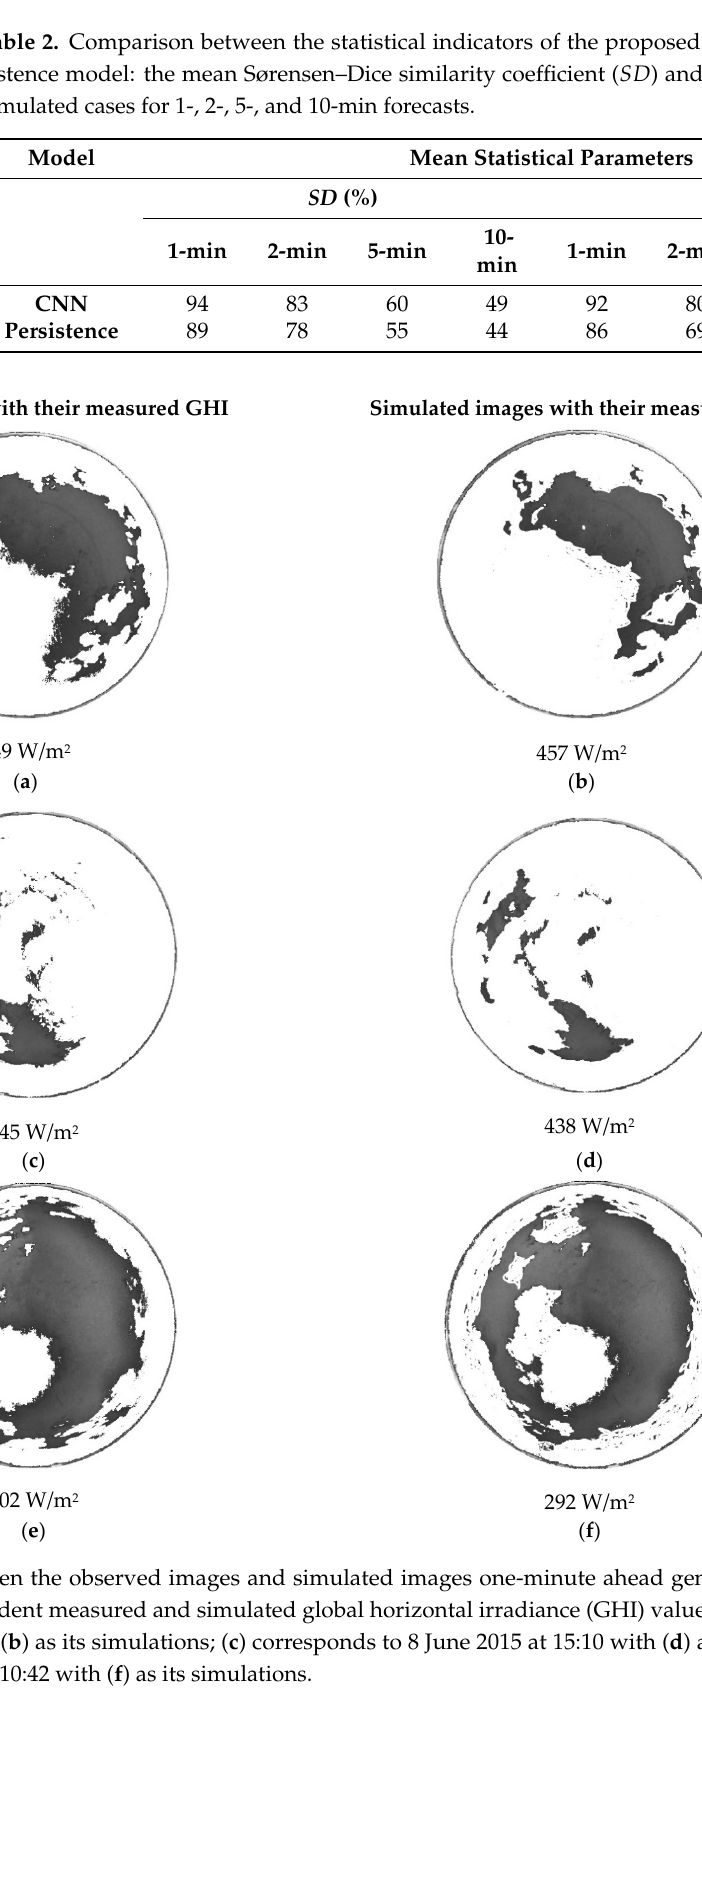
observed images with their corresponding simulated values. Figure 6 shows the distribu- tion of the relative deviations as a boxplot for different time horizons.